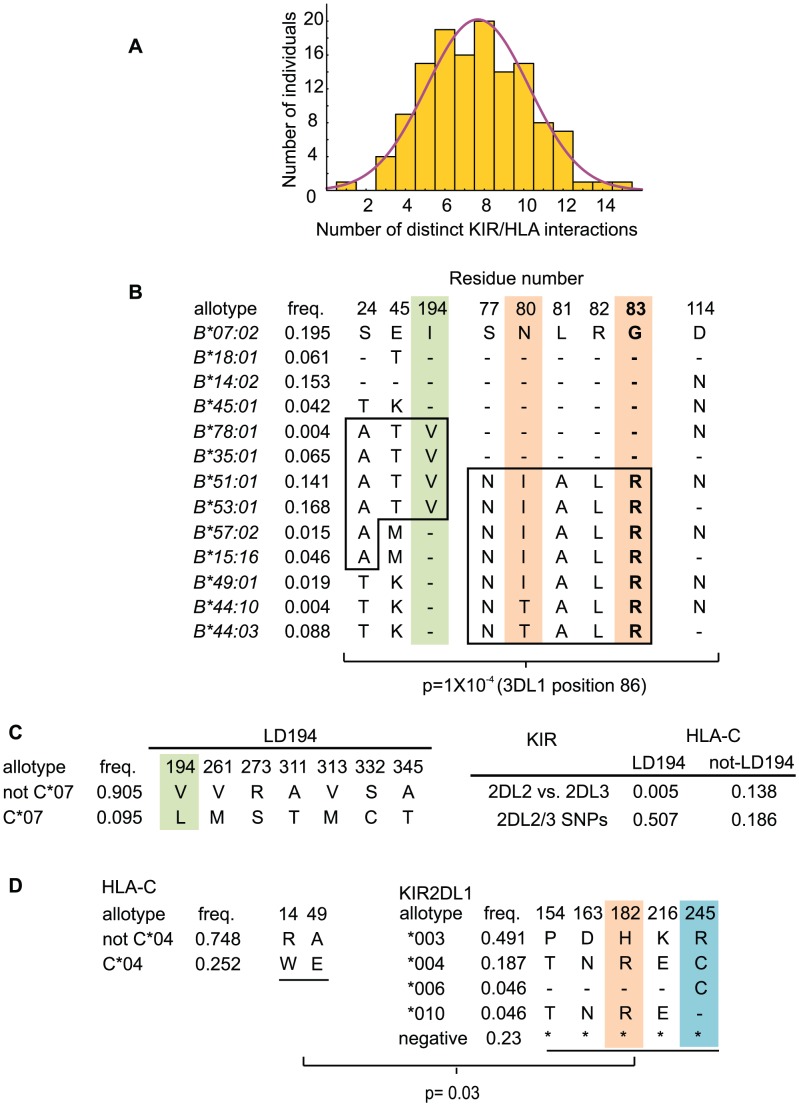
Population-specific co-evolution of HLA and KIR.A. Plotted is the total number of distinct viable receptor:ligand allotype pairs per individual. The viable interactions are shown in Figure 5. The individual with only one unique interaction, KIR2DL2*001/HLA-C*04:01 is homozygous for common HLA (A*23:01, B*44:03, C*04:01) and KIR (KIR2DL2*001, KIR2DL1/S1/S2 negative, KIR3DL1*004 (non-expressed)) haplotypes. B. Shown are the results of a Mantel test for correlation between distance matrices generated from SNP genotypes of HLA-B and KIR3DL1/S1. Distance matrices of genotypes defined by the nine HLA-B residues shown correlate (p = 0.0001) with those of KIR3DL1 position 86 (refers to residues 31, 44 and 86, which are in perfect LD. Presence of leucine at residue 86 disrupts cell-surface expression of KIR3DL1 [57] (Figure S13)). Orange indicates KIR-contacting residues, green indicates LILR binding residue. R83, which is critical for binding to KIR3DL1, is shown in bold [65]. Groups of residues in LD are boxed. C. (Left) shows the group of HLA-C residues (LD194; which distinguish C*07 from the other HLA-C in Ga-Adangbe) whose genotypes correlate with those of KIR2DL2/3 (p = 0.005). (Right) shows the results of Mantel tests performed using the LD194 group, and HLA-C genotypes with them removed (not-LD194). 2DL2 vs. 2DL3 refers to the set of residues that distinguish KIR2DL2 from KIR2DL3, and 2DL2/3 SNPs is the set of residues that vary but do not discriminate KIR2DL2 from KIR2DL3 (See Figure S2). D. Shows the groups of HLA-C and KIR2DL1 residues that correlate with each other. Genotypes defined by HLA-C residues 14 and 49 correlate with those defined by residues 154, 163, 182, 216 and 245 of KIR2DL1. Orange indicates KIR-contacting residues, blue shows residue 245 that disrupts KIR2DL1 function [73]. B–D. Allotype names are at the left and where the motif is identical, only the most common allotype is shown.